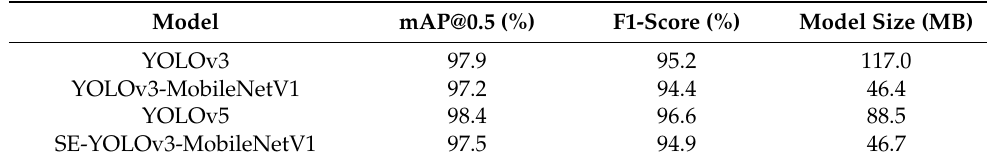
Table 2. Performance comparison of four models.